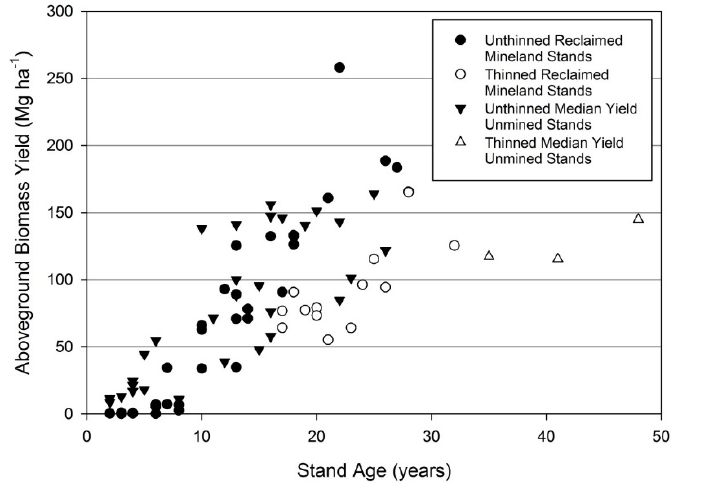
Figure 8. Total aboveground biomass yield when dry for loblolly pine stands on reclaimed mineland in east Texas. Unmined comparison data from multiple studies compiled in Gonzalez-Benecke, et al. [31] which display the median aboveground biomass yield obtained within each